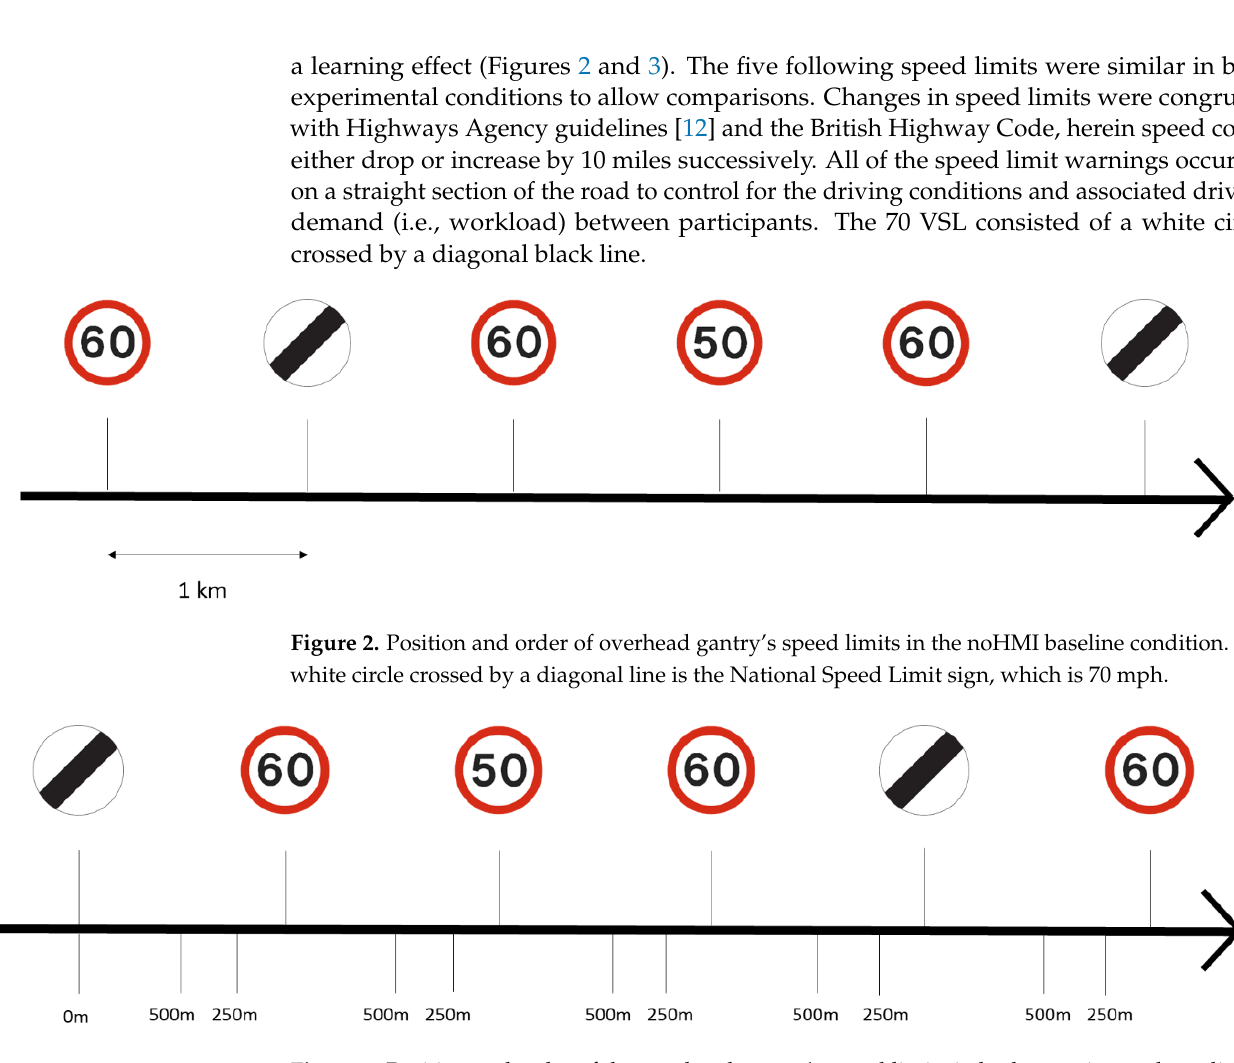
Figure 3. Position and order of the overhead gantry’s speed limits in both experimental conditions (i.e., trig250 m & trig500 m). The triggers for the speed limits conveyed by the in-vehicle app are shown below the axis.